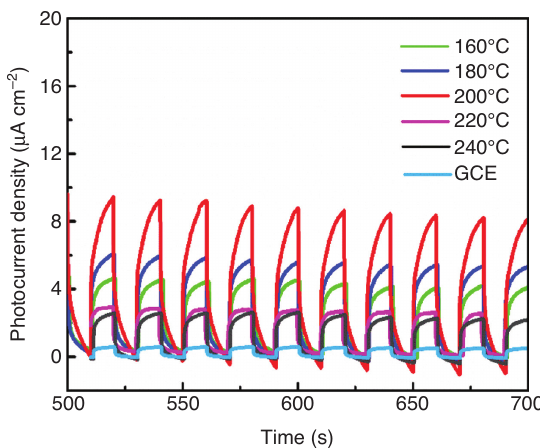
Figure 4: Transient photocurrent density vs. time plotted for NGQDs/GCE in BR buffer solution (pH 4.0) containing 0.1 mm DA under UV light illumination. The illumination from an Xe lamp was interrupted every 10